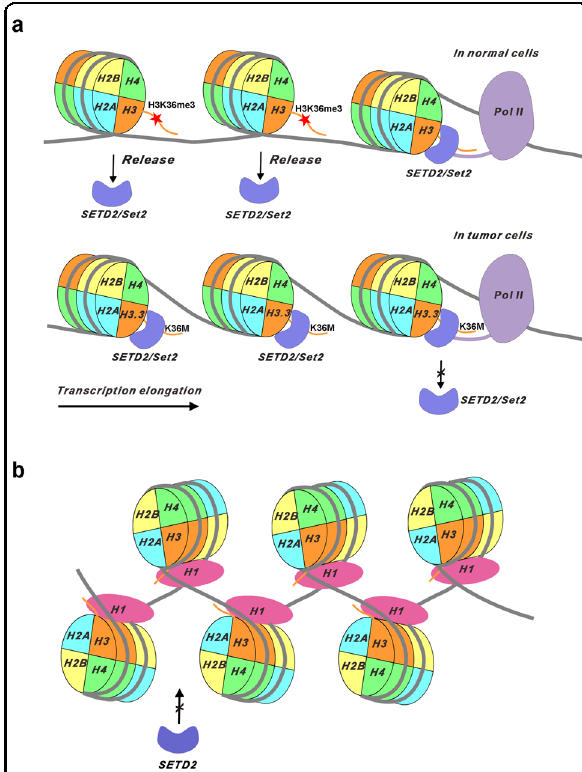
Fig. 5 A working model for the actions of SETD2 on nucleosomes. a In normal cells, SETD2/Set2 directly associates with RNA Pol II and implements H3K36 methylation on partially unwrapped nucleosomes, co-transcriptionally. After that, SETD2/Set2 is rapidly released from the nucleosomes, and the DNA wraps back to its canonical conformation. However, in cancer cells carrying the oncogenic H3.3K36M mutations, SETD2/Set2 is withheld on the H3.3K36M nucleosome, which impairs the normal functions of SETD2/ Set2 and possibly affects the movement of RNA pol II during transcription elongation. b A schematic drawing shows that histone H1 stabilizes the compact conformation of the nucleosome and prohibits the binding of SETD2 on the